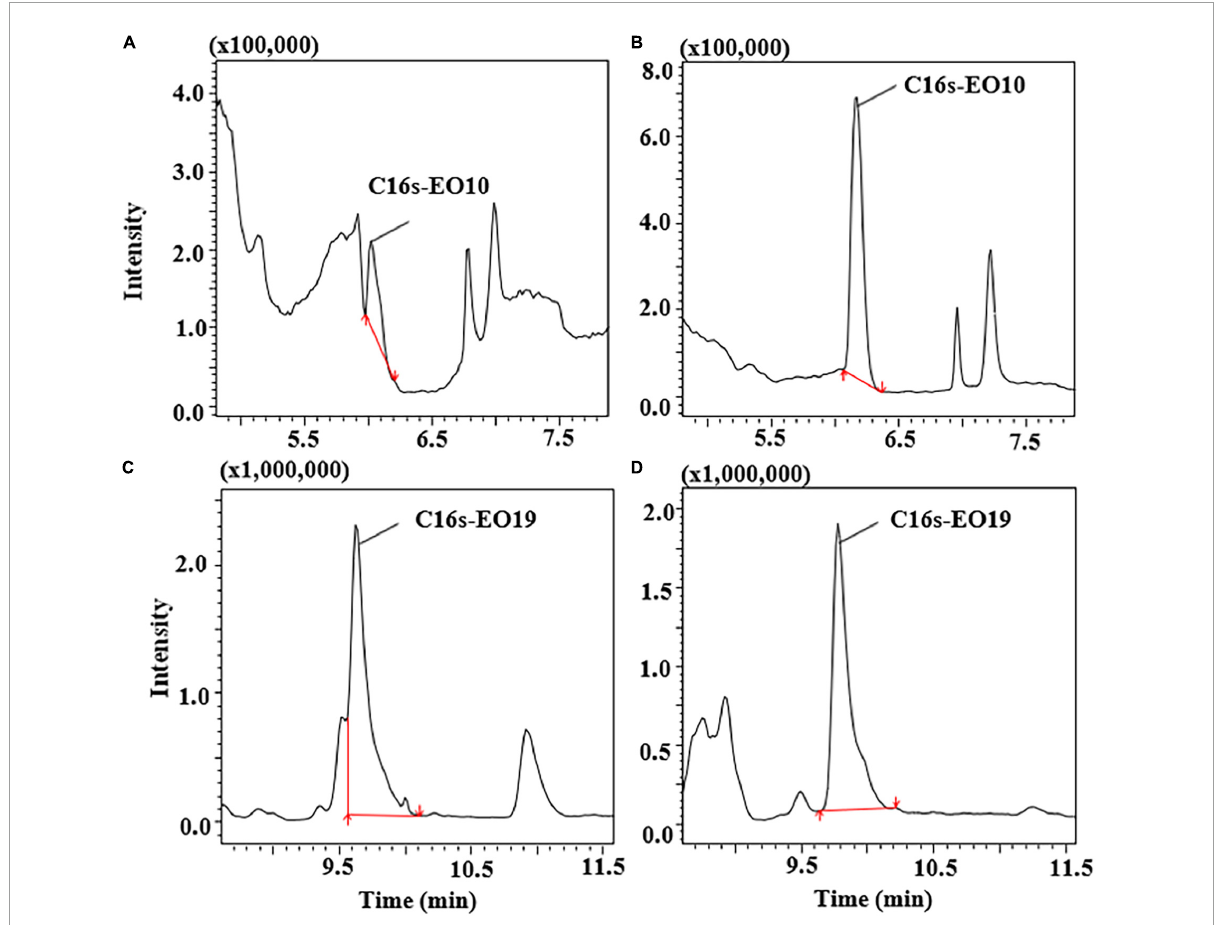
FIGURE3 The ion chromatograms of C16s-EO10 and C16s-EO19 in different solvent extraction performances. (A) C16s-EO10 extracted by 1.5% formic acid in acetonitrile, (B) C16s-EO10 extracted by 1% formic acid in acetonitrile, (C) C16s-EO19 extracted by 0.1% formic acid in acetonitrile, and (D) C16s-EO19 extracted by 1% formic acid in acetonitrile. The spiked levels were 0.2 mg/L POE-5 and 1 mg/L